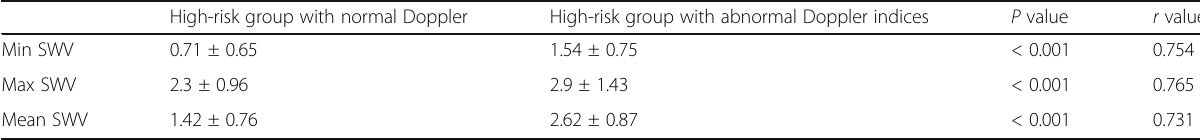
Table 4 Comparison between SWV in the placenta of high-risk pregnancy with normal and abnormal Doppler flow High-risk group with normal Doppler High-risk group with abnormal Doppler indices